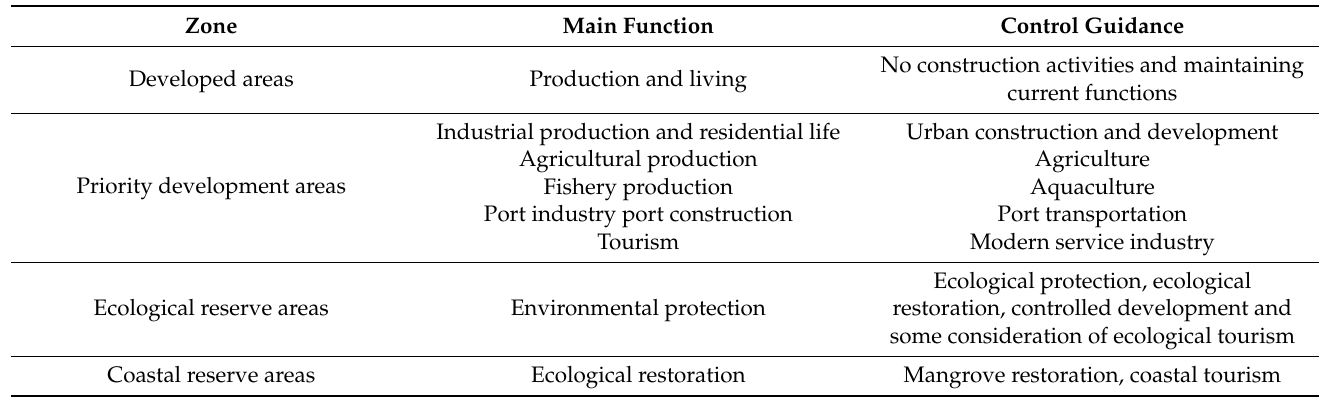
Table 9. Zoning layout and control guidance for the study